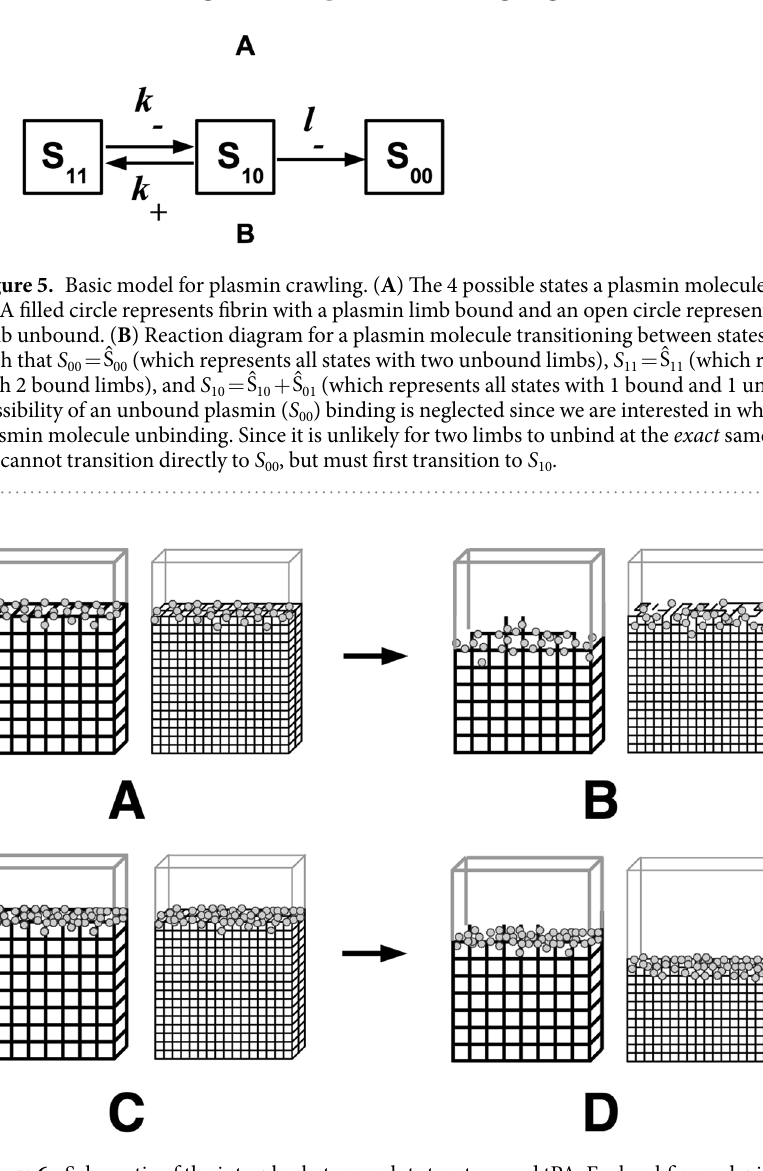
fibrin, tPA molecules quickly accumulate at the clot front. So 1.0 mL of 5-nM tPA solution results in similar lysis as 0.1 mL of 50-nM tPA. The fast diffusion and strong binding of tPA quickly localize the molecules to the clot front. This accounts for the complex relationship between clot structure and lysis rates. With a large number of tPA molecules, there is enough tPA to start lysis on all fibers at the lysis front in both fine and coarse clots. Since the thin fibers in the fine clot lyse faster than the thick fibers in the coarse clot, the fine clot degrades more quickly (Fig. 6C,D). However, with a small number of tPA molecules, there is enough tPA to start lysis on all fibers at the